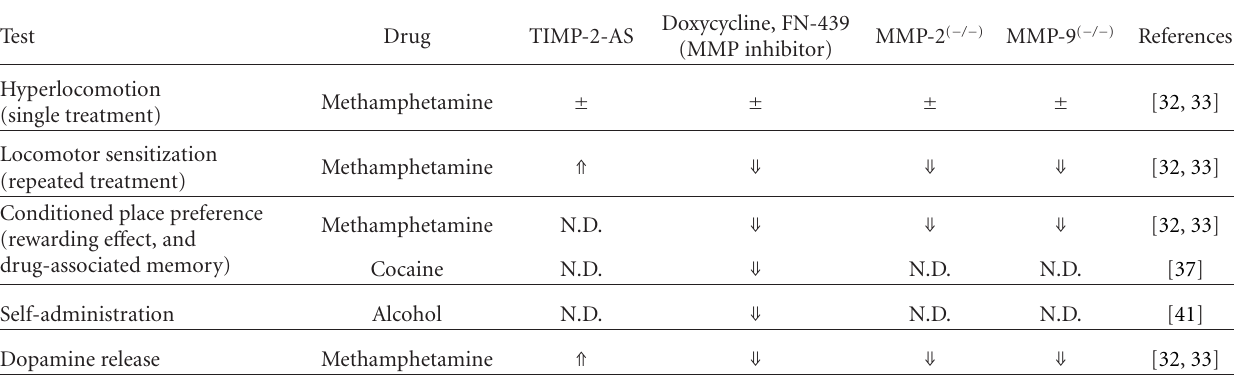
Table 4: Summary of changes in addictive behaviors and dopamine release in response to inhibition of the MMP/TIMP system.